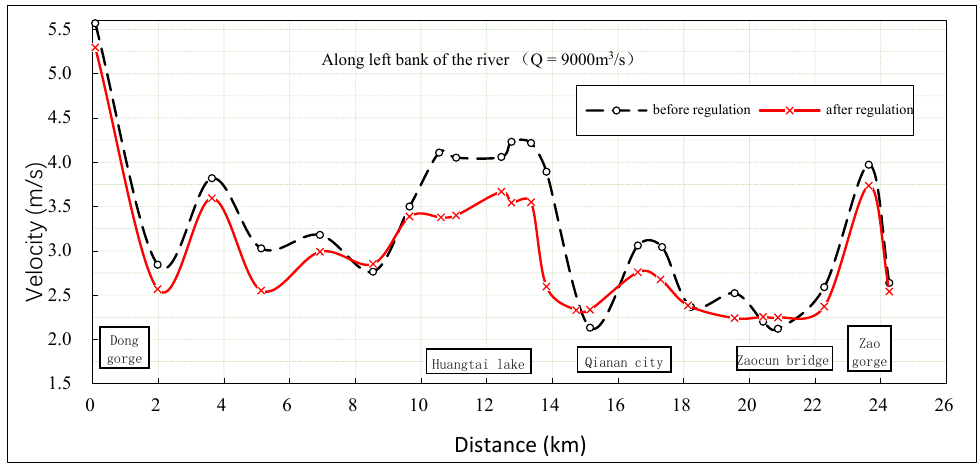
Figure 8. Comparison between Case S1 and Case S2 for the velocity along the left bank.